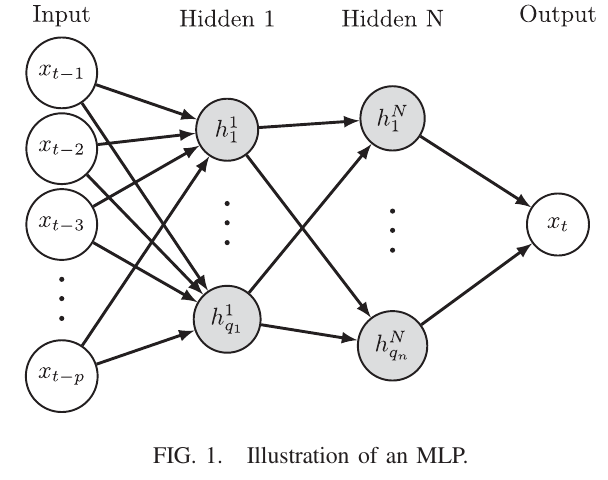
FIG. 1. Illustration of an